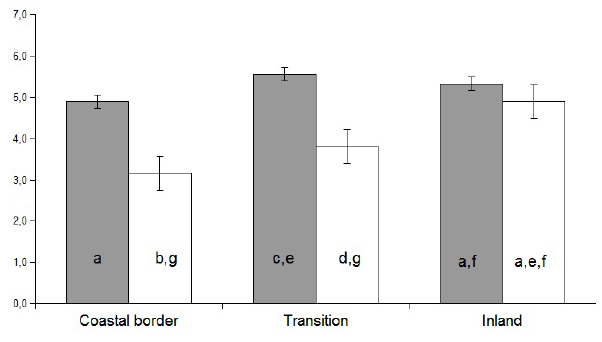
Fig. 4 . Average user groups’ perceptions of community and own household well-being conditions before (retrospectively measured; grey bars) and after (white bars) the 2010 earthquake; well-being is scored using the Chilean school grading scale; 1 is the lowest mark and 7 the highest; error bars represent standard deviation; significant differences are represented by different letters and analyzed with one-way analysis of variance (ANOVA) and Dunn’s posteriori